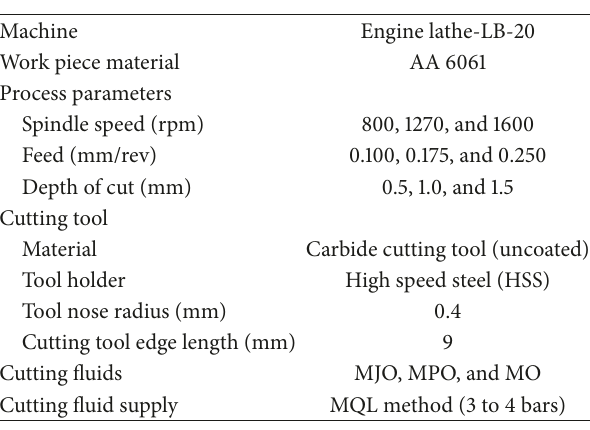
Table 3: Machining conditions.